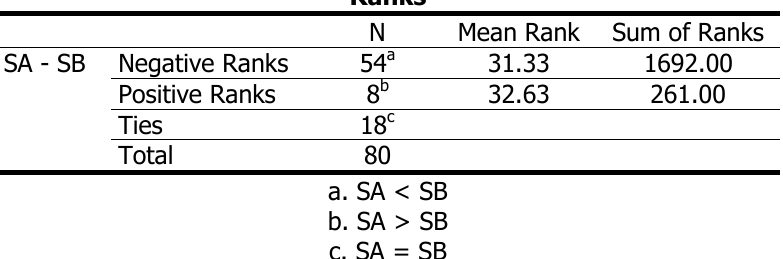
Table 8. Wilcoxon Signed Ranks Social Motivation Test